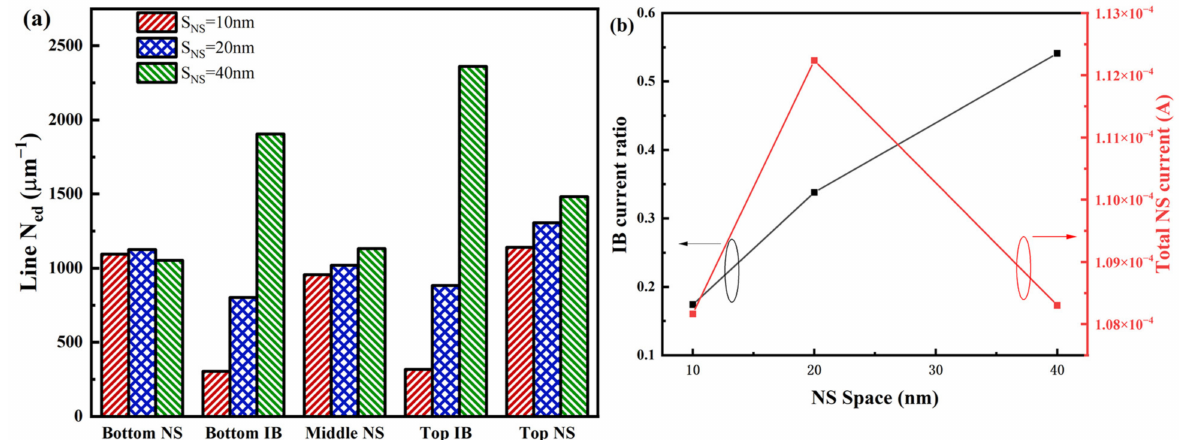
Figure 9. ( a ) Total line electron density (N ed ) of different parts of channels with different S NS ; ( b ) the IB current ratio=the total IB current/ the total current; total NS current.